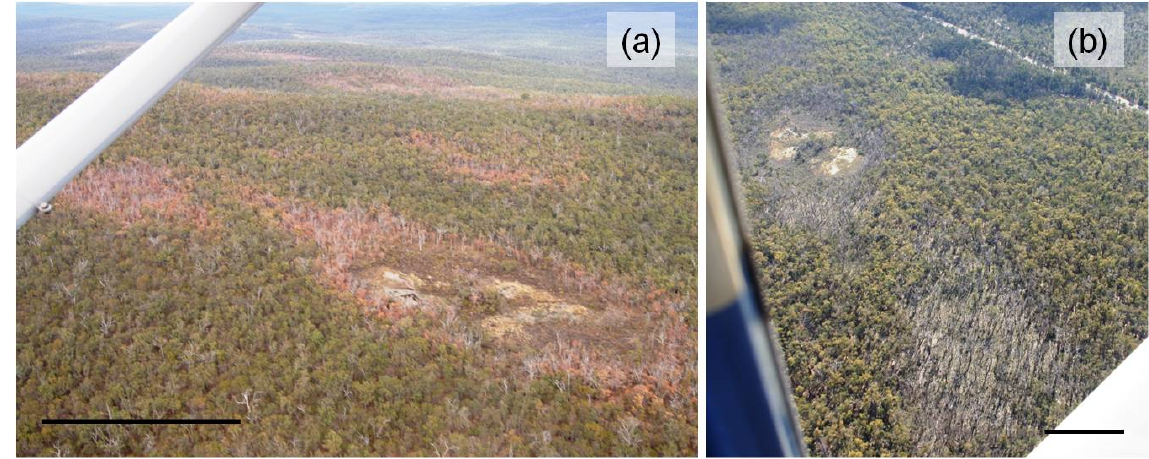
Figure 1. Aerial photo of an area of the Northern Jarrah ( Eucalyptus marginata ) Forest, Western Australia (Site 74), at ( a ) three and ( b ) 16 months following drought. Scale bar represents approximately 200